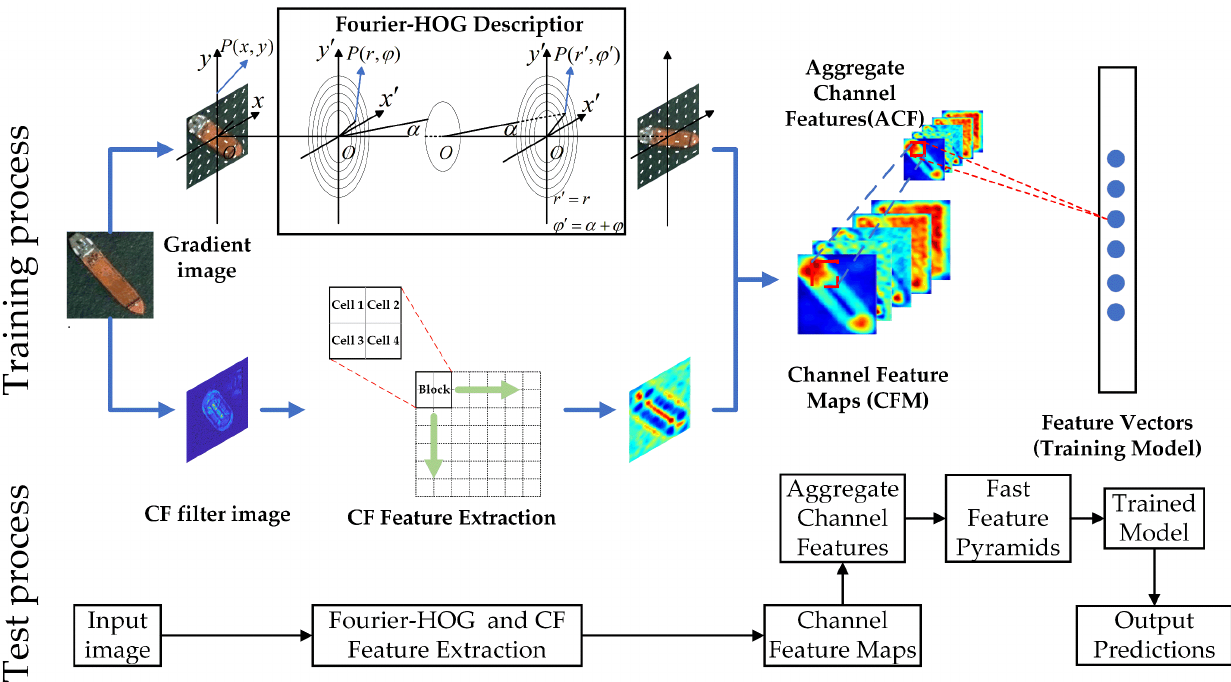
Figure 11. The flowchart of the proposed ship identification framework.